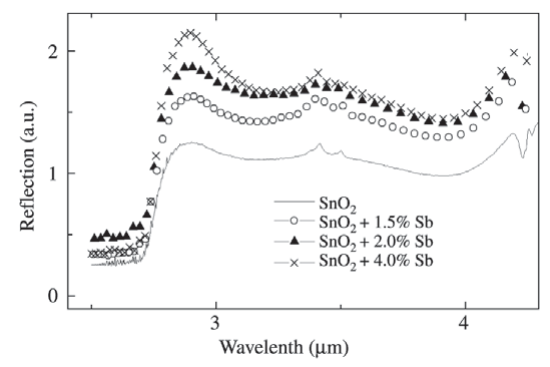
Figure 2. Near infrared reflection spectra for SnO deposited by PII.